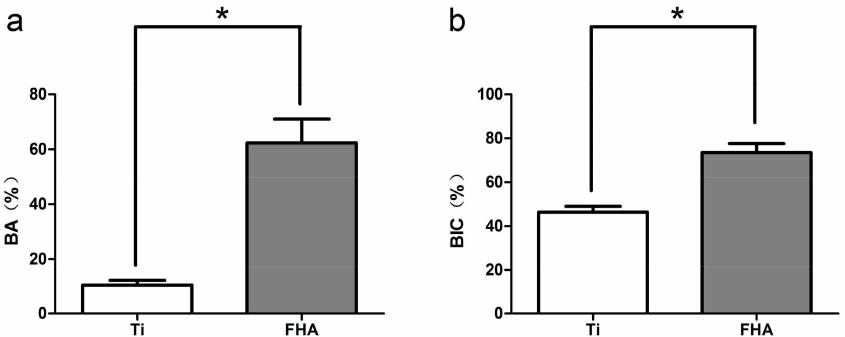
Figure 11. ( a ) Bone area ratio (BA) and ( b ) bone–implant contact (BIC) in Ti and FHA-coated implants. * p < 0.05.